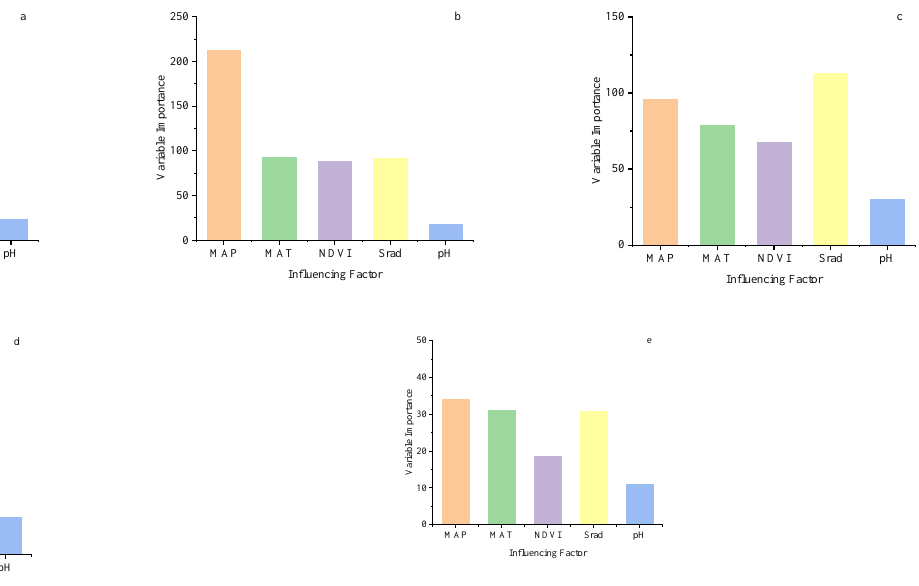
Figure 5. Different environmental variables’ relative role in determining the distribution of soil TN content. Note: PS: Pontic Steppe; MES: Middle East Steppe; KS: Kazakh Steppe; KSD: Kazakh Semi-Desert Steppe; KFS: Kazakh Forest Steppe; MAT: mean annual temperature; MAP: mean annual precipitation; Srad: solar radiation; pH: soil pH; NDVI: Normalized Difference Vegetation Index. ( a ): Influence of different climatic conditions on soil TN fluctuation in Pontic Steppe; ( b ): Influence of different climatic conditions on soil TN fluctuation in Middle East steppe; ( c ): Influence of different climatic conditions on soil TN fluctuation in Kazakh Steppe; ( d ): Influence of different climatic conditions on soil TN fluctuation in Kazakh Semi-Desert steppe; ( e ): Influence of different climatic conditions on soil TN fluctuation in Kazakh Forest steppe.